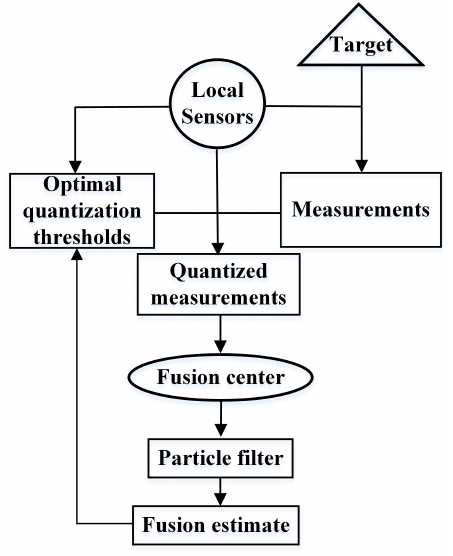
Figure 2. Flow chart of artificial measurements-based adaptive